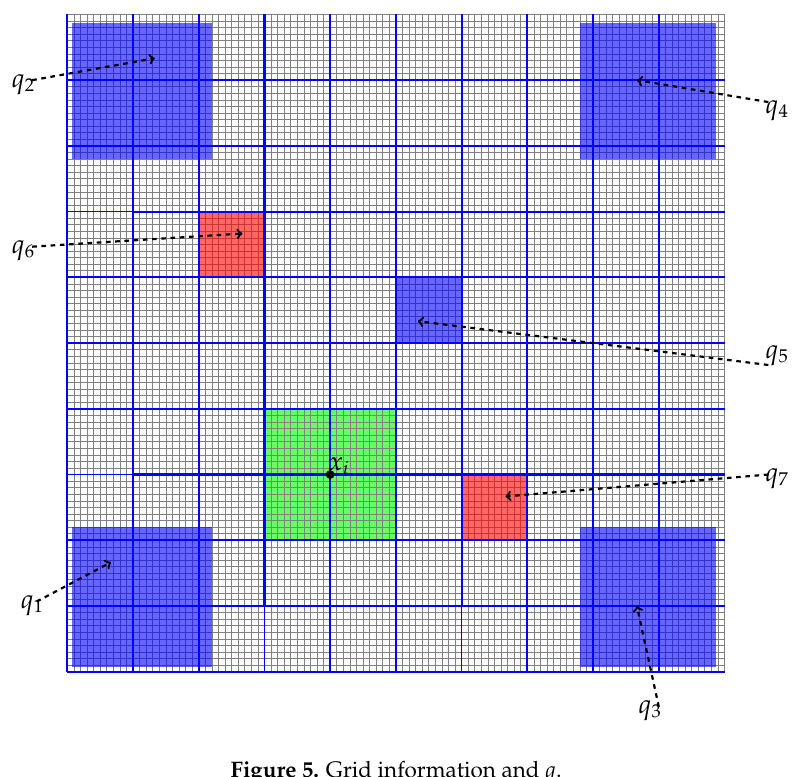
Figure 4. Logarithm of permeability field.